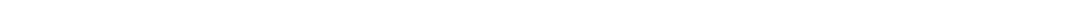
Fig. 2 Mesenchymal HGSOC accumulate mostly the CAF-S1 subset. a Representative views of CD29, SMA, FAP, PDGFR β , and FSP1 immunostaining of serial sections in CAF-S4- or CAF-S1-enriched HGSOC. Scale bar, 100 μ m. b Decision tree used to de fi ne CAF identity, based on four equal quartiles (Q) and median (Mdn) distribution of each CAF marker intensity. Thresholds (Mdn, Q) and order of decisions were fi rst established from FACS data of a prospective cohort of HGSOC patients ( N = 22) and next transposed to values of IHC data, using a learning set of tumors containing both non-activated and activated CAF ( N = 60). c Bar plot showing percentage of HGSOC according to the predominant CAF subset detected in each tumor. CAF enrichment per tumor is de fi ned by applying the histological scores of all markers on the decision tree described in ( b ). HGSOC enriched in CAF-S1 (red), CAF-S2 (orange), CAF-S3 (green), or CAF-S4 (blue) are shown as percentage (%). N = 118 HGSOC patients. d Same as in ( c ) considering mesenchymal ( N = 66) versus non-mesenchymal ( N = 49) HGSOC. P values are from Fisher ’ s exact test. e Maps of CAF subsets at cellular level, corresponding to the tumor sections shown in ( a ). Each square of 225 μ m 2 corresponded on average to a single cell. Each CAF subset is represented by a color code and epithelial cells are in grey. The bar plot shows the percentage of HGSOC according to the predominant CAF subset evaluated on CAF maps at cellular level ( N = 9). f Representative views of CAF maps, with their corresponding heatmaps showing the distances (shortest in red, farthest in yellow) between cancer cells and CAF subsets. Scatter plots show the distance to epithelial cells according to CAF subsets (distance calculated in a maximum area of fi ve successive tiles in x and y ). Data are shown as mean ± SEM ( n = 425 cells per image in average). P values are from Student ’ s t -test. g Representative images showing triple immuno fl uorescence co-staining of CD29 (red), FAP (green), and SMA (violet) markers in HGSOC enriched in CAF-S1 (arrowheads) or CAF-S4 (arrows). Scale bar, 50 μ